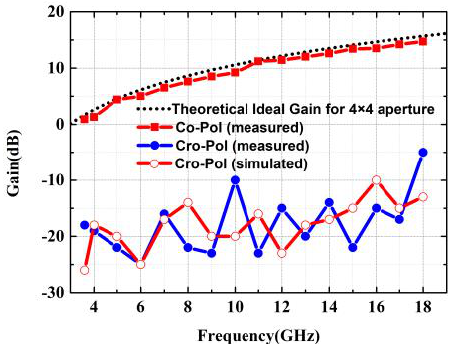
co-polarized gains.